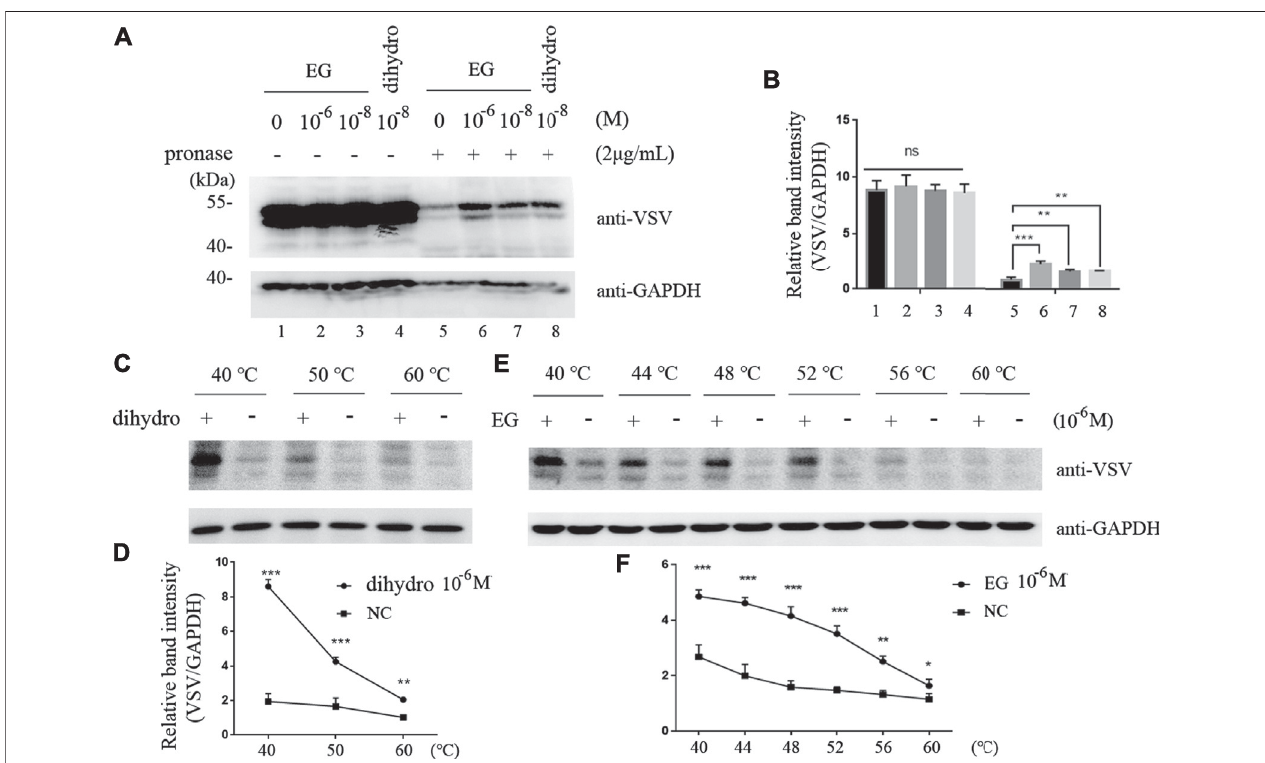
FIGURE 2 | EG interaction with 5-HT 1B in DARTS and CETSA experiments. (A,B) Intact Flp-In ™ T-REx ™ 293 cells stably induced to express mGluR5-VSV-G-5-